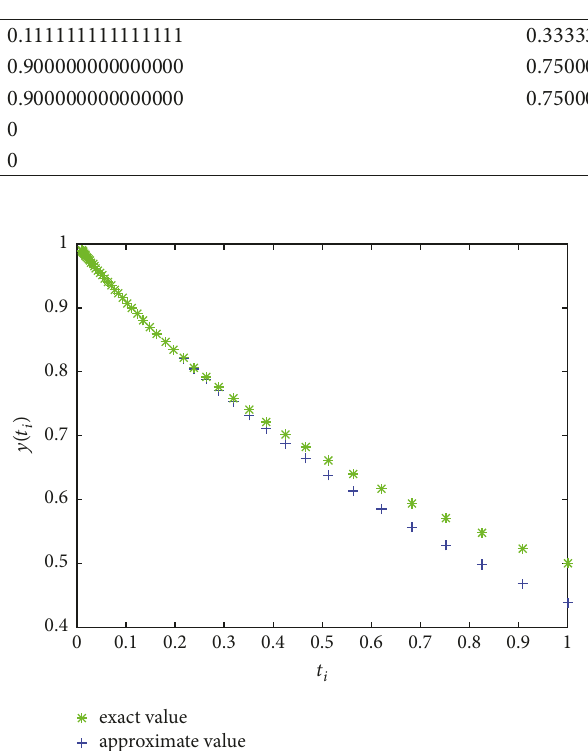
Figure 1: For 𝑞 = 1.1,𝑁 0 = 50